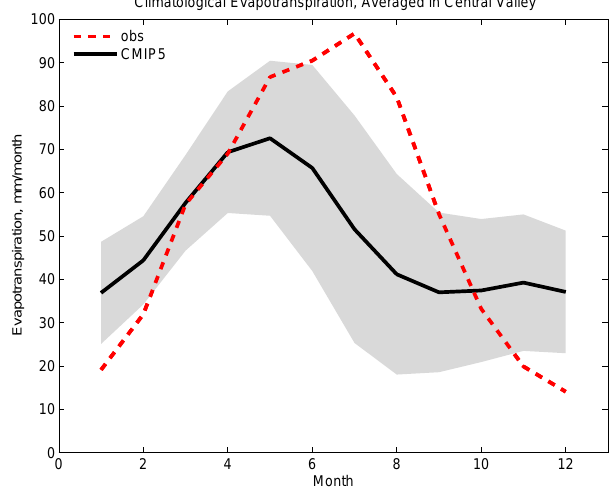
Figure 7. Mean seasonal cycle from the CMIP5 suite of mod- els compared against satellite-observed ET. Solid line shows mean value of CMIP5 model members and shaded region shows uncer- tainty (2 standard deviations around